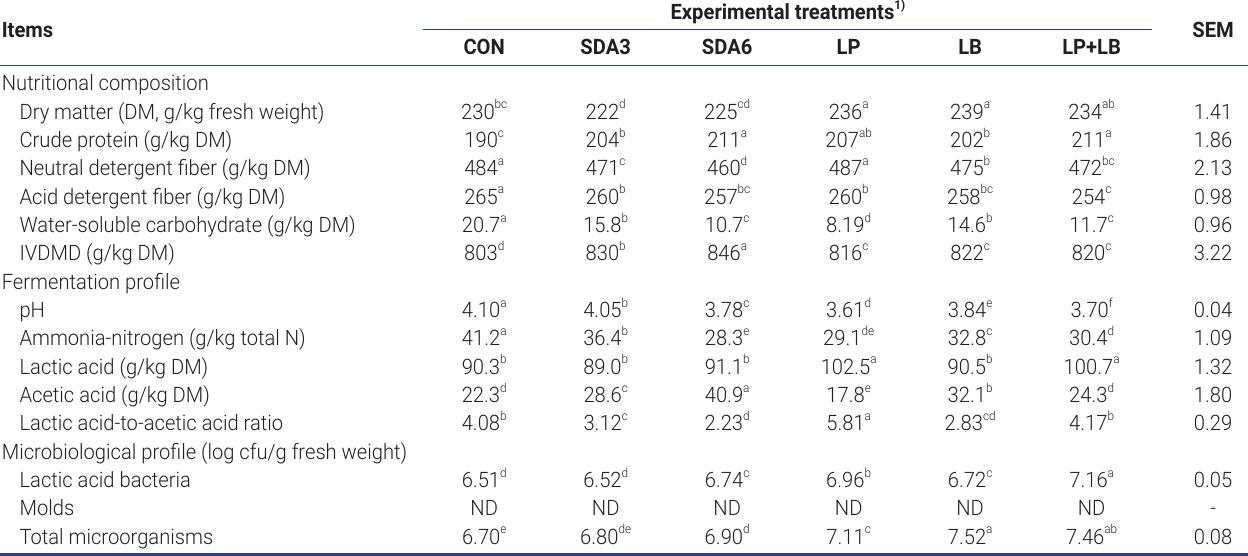
Experimental treatments 1)